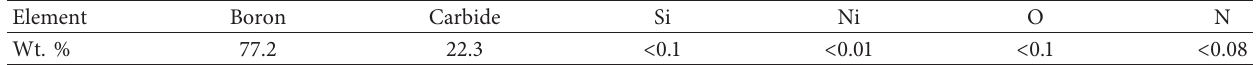
Table 1: Chemical analysis of boron carbide particles.